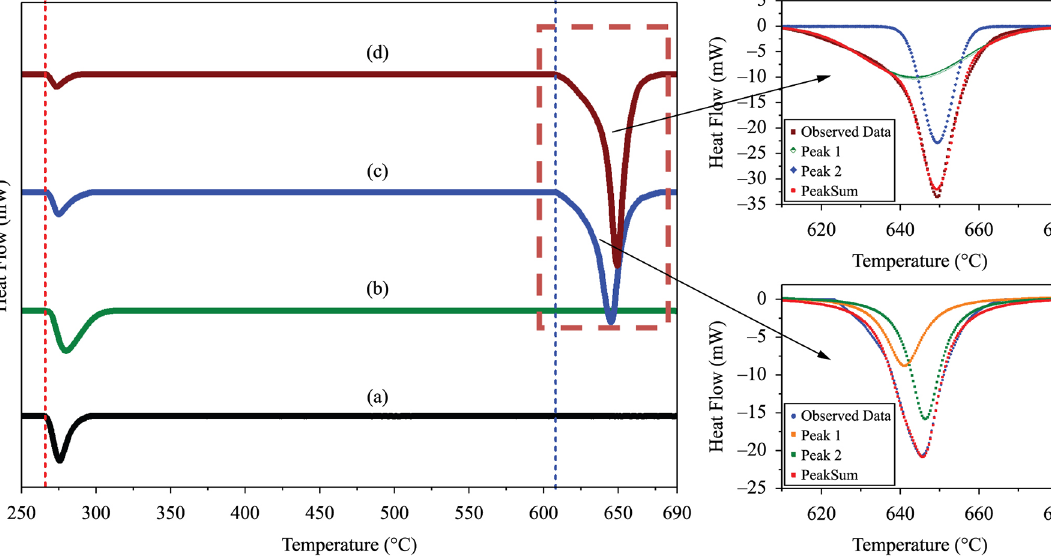
Sb , (b) Bi Sb , (c) Bi Sb , and (d) Bi Sb , 0.88 0.12 0.75 0.25 0.50 0.50 0.25 0.75